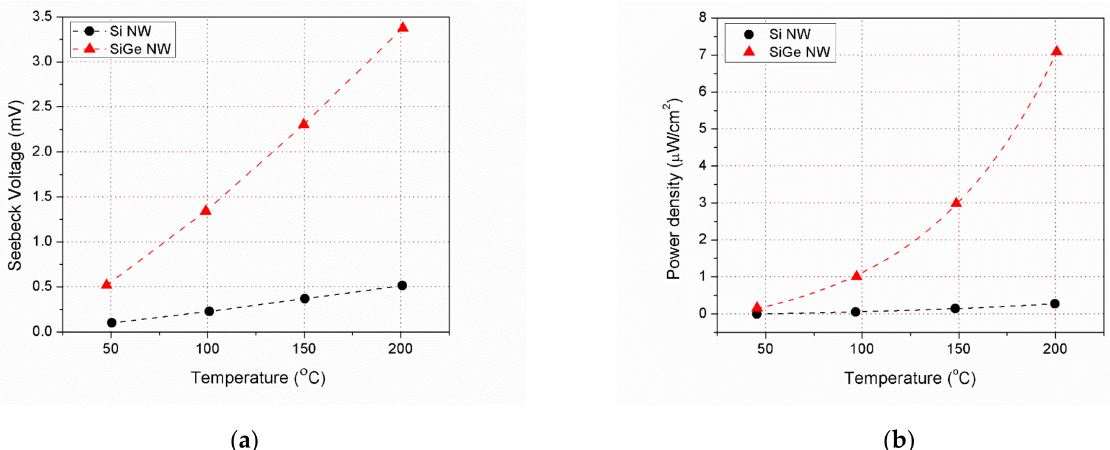
Figure 3. ( a ) Seebeck voltage (open circuit voltage) as a function of hotplate temperature measured for Si and SiGe NWs devices; ( b ) Maximum electrical power density obtained in both types of devices in the same temperature conditions.